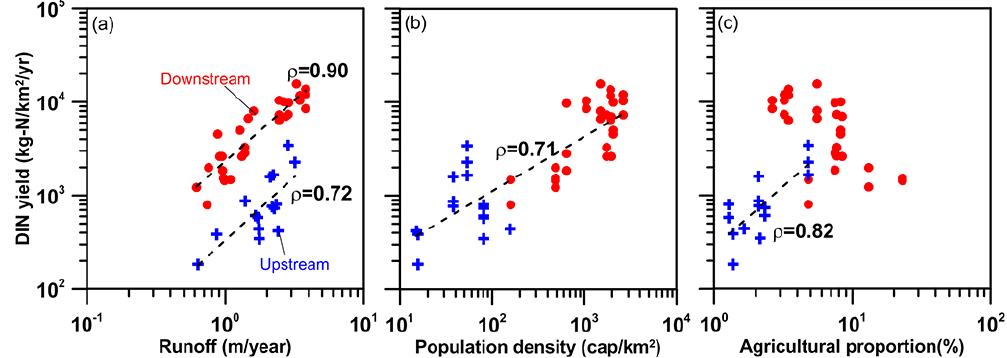
Figure 5. Annual DIN yields plotted against (a) runoff, (b) population density and (c) agricultural proportion at our sampling sites. Red circles and blue crosses represent downstream and upstream sites, respectively. The relationships are individually examined in terms of Pearson correlation coefficients ( ρ ) for the upstream and downstream subsets and the data set as a whole. Fitted lines are drawn only if ρ values are greater than 0.70. Table 5. Yield equations as a function of annual runoff and population density. Smith et al. (2005) generated different yield equations for different basin size groups. Table 5. Data source Basin Intercept a Runoff Population No. R 2 Est. Danshui DIN size (km 2 ) coeff. coeff.